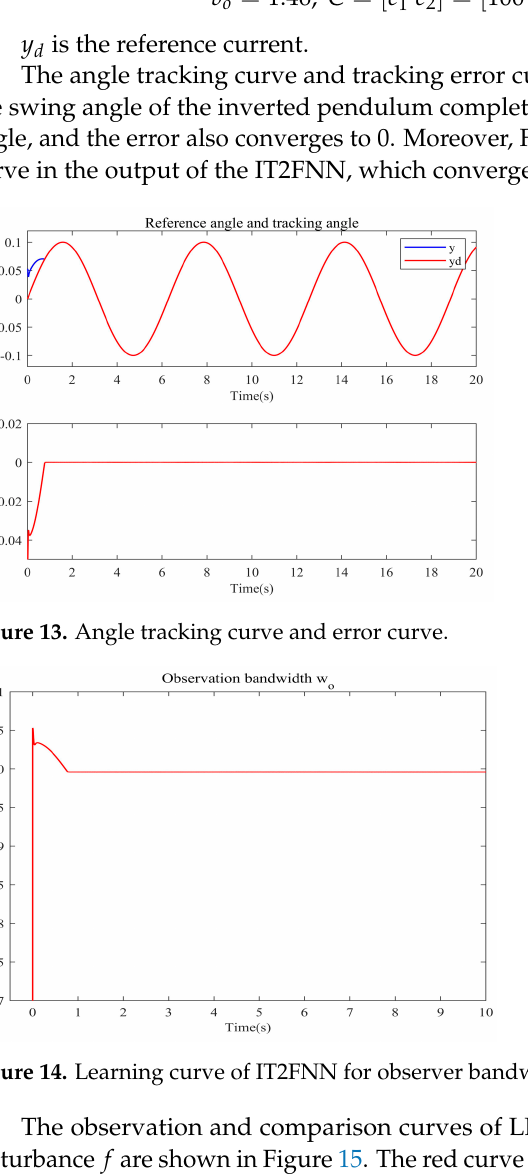
Figure 14. Learning curve of IT2FNN for observer bandwidth w o in the inverted pendulum tem.